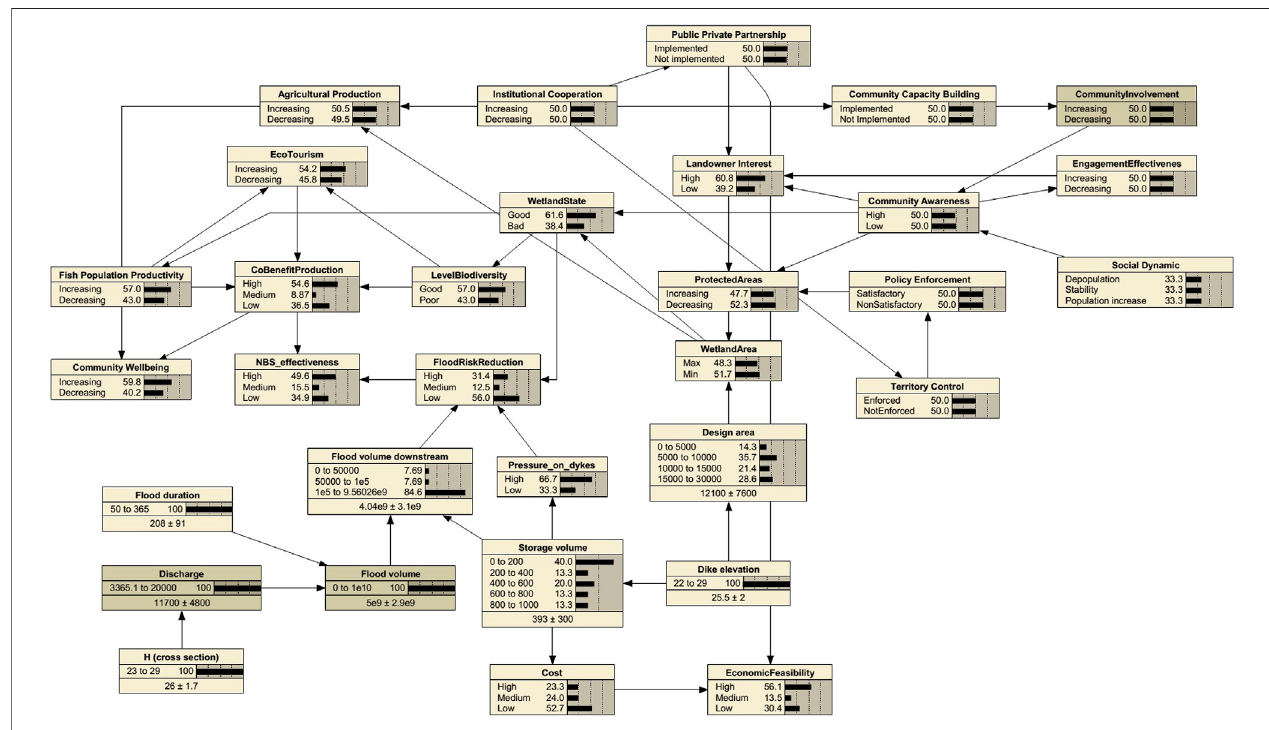
FIGURE 8 | Integrated BBN for the study area.